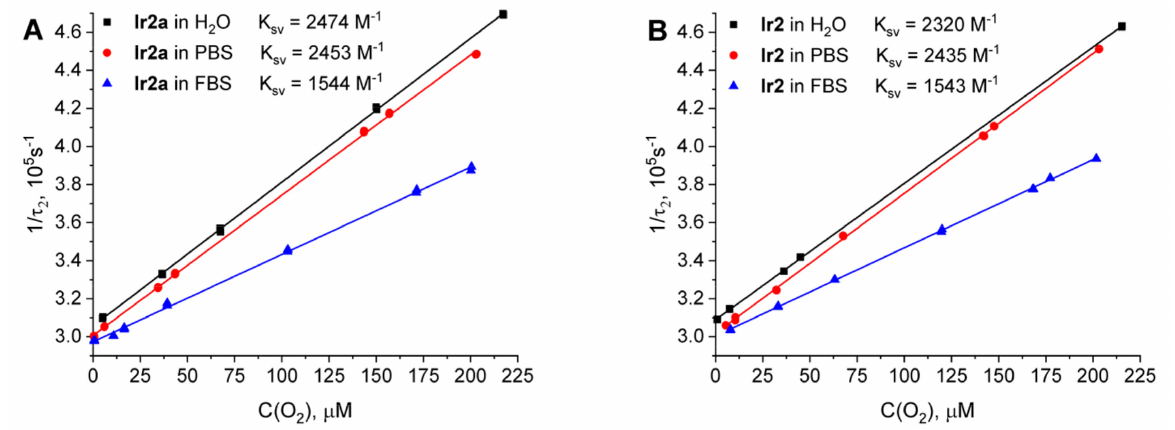
Figure 4. Stern–Volmer oxygen quenching plots for Ir2 ( A ) and Ir2a ( B ) in aqueous solution, 0.01 M phosphate buffered saline (pH 7.4) and in fetal bovine serum (T = 37 ◦ C). (K sv -Stern–Volmer